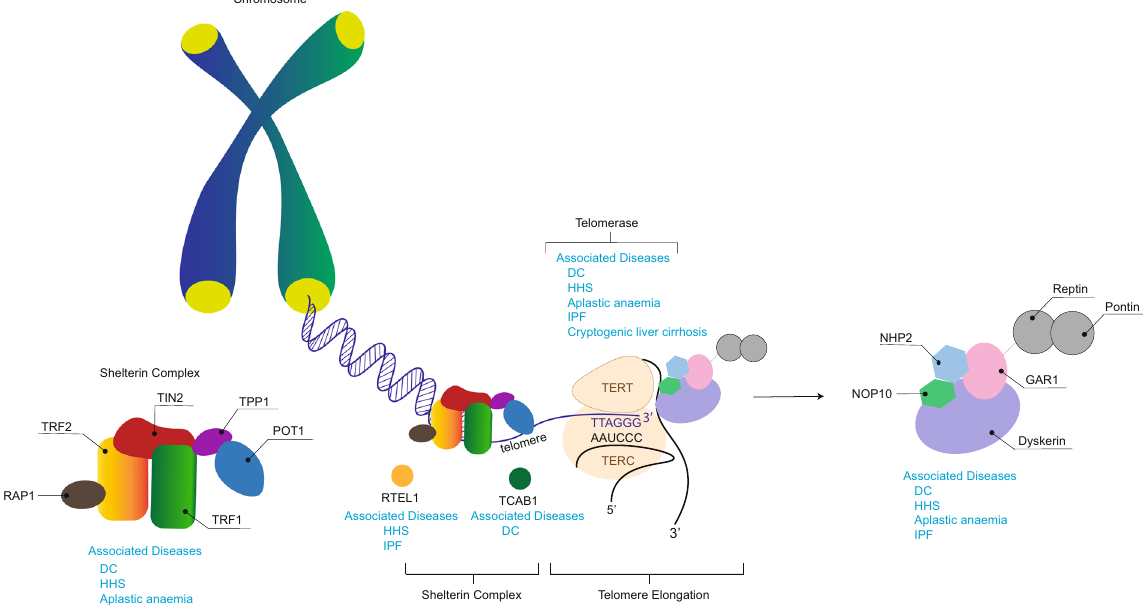
Fig. 2 Telomere and telomerase complex components and their associated diseases. Telomeres are noncoding tandem repeats of the sequence TTAGGG , found at the ends of chromosomes in a duplex “ D-loop-T-loop ” con fi guration. RTEL1 is a helicase that disrupts T-loops for telomere replication and repair. Shelterin protects telomeres from DNA damage surveillance and comprises of six polypeptide components: TRF1, TRF2, RAP1, TIN2, TPP1 and POT1. Telomerase comprises of the essential components TERT and TERC, which synthesise telomeres and maintain telomere length. Dyskerin forms a complex with NHP2, NOP10 and GAR1. It binds to TERC to stabilise the telomerase complex. TCAB1 regulates the recruitment of telomerase to telomeres. Mutations in any of these components results telomere dysfunction, manifesting as telomere biology disorders. DC, dyskeratosis congenita; GAR1, H/ACA ribonucleoprotein complex subunit 1; HHS, Hoyeraal – Hreidarsson Syndrome; IPF, idiopathic pulmonary fi brosis; NHP2, H/ACA ribonucleoprotein complex subunit 2; NOP10, H/ACA ribonucleoprotein complex subunit 3; POT1, protection of telomeres 1; RAP1, repressor/activator protein 1; RTEL1, regulator of telomere length 1; TCAB1, Telomerase Cajal body protein 1; TERT, telomerase reverse transcriptase; TERC, telomerase RNA component; TIN2, TRF1-interacting nuclear protein 2; TPP1, TIN2-interacting protein 1; TRF1, telomere repeat-binding factor 1; TRF2, telomere repeat-binding factor